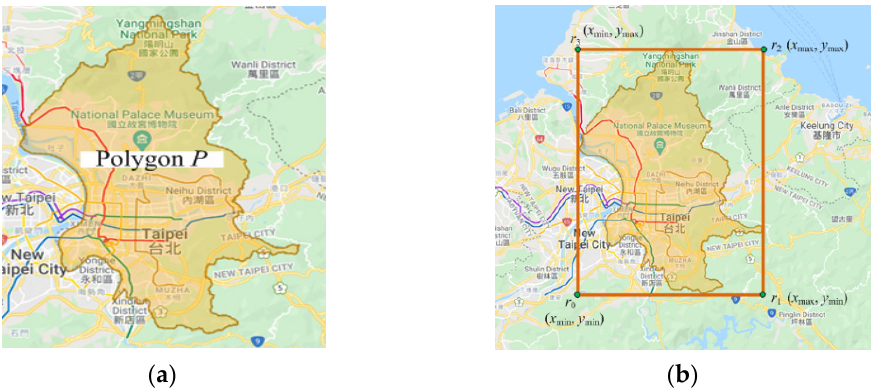
Figure 5. Polygon of the city and a minimal rectangle covering the polygon. ( a ) Polygon of the city; ( b ) Minimal rectangle covering the polygon.